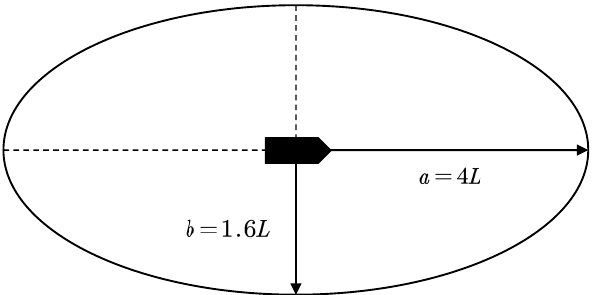
Figure 1. Ship domain of Fuji.